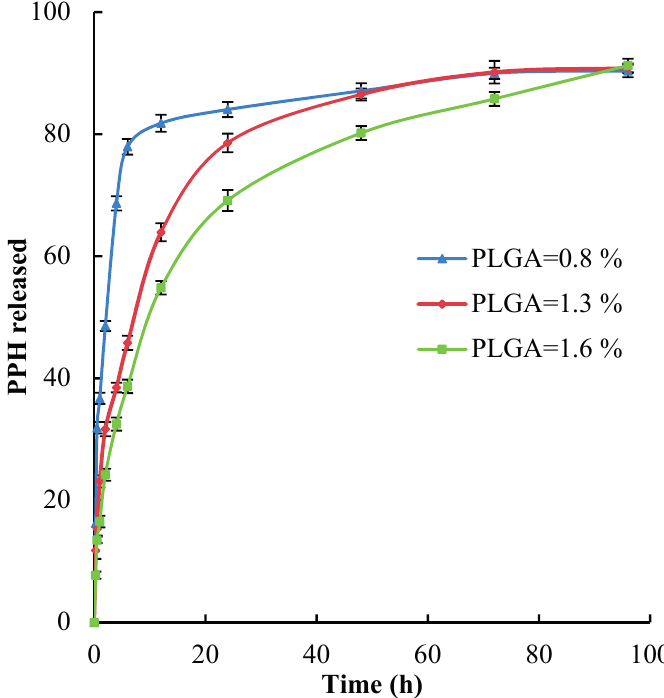
Figure 3. The in vitro PPH release profile from NPs at T = 310.15 K in phosphate buffered saline, pH 7.4 for the same amount of drug: Results for different concentration of PLGA ( w / v ): ( ▲ ) 0.8%, ( ♦ ) 1.3%, ( ■ )